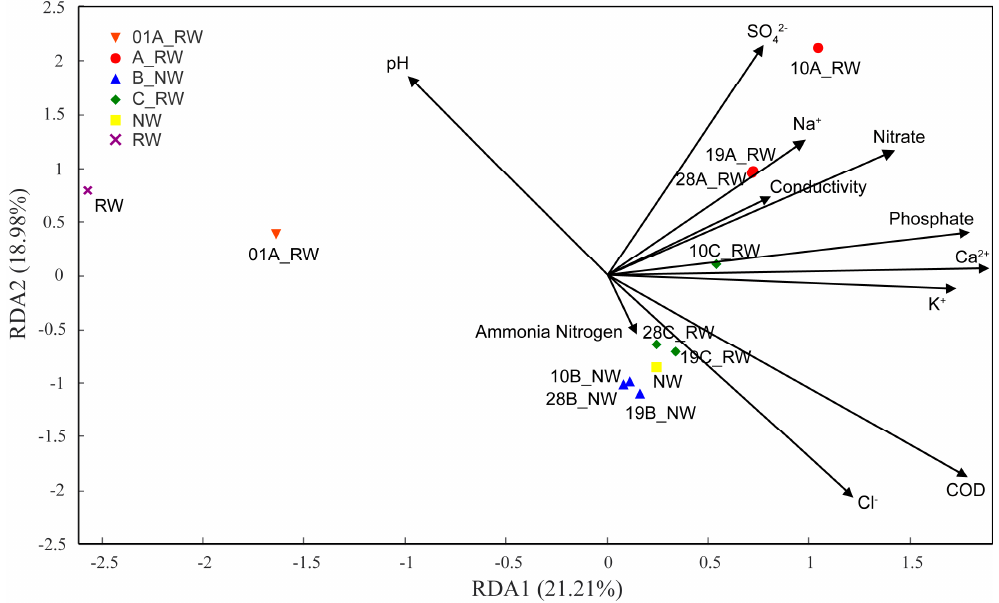
Figure 5. Correlation between microbial community and environmental factors.